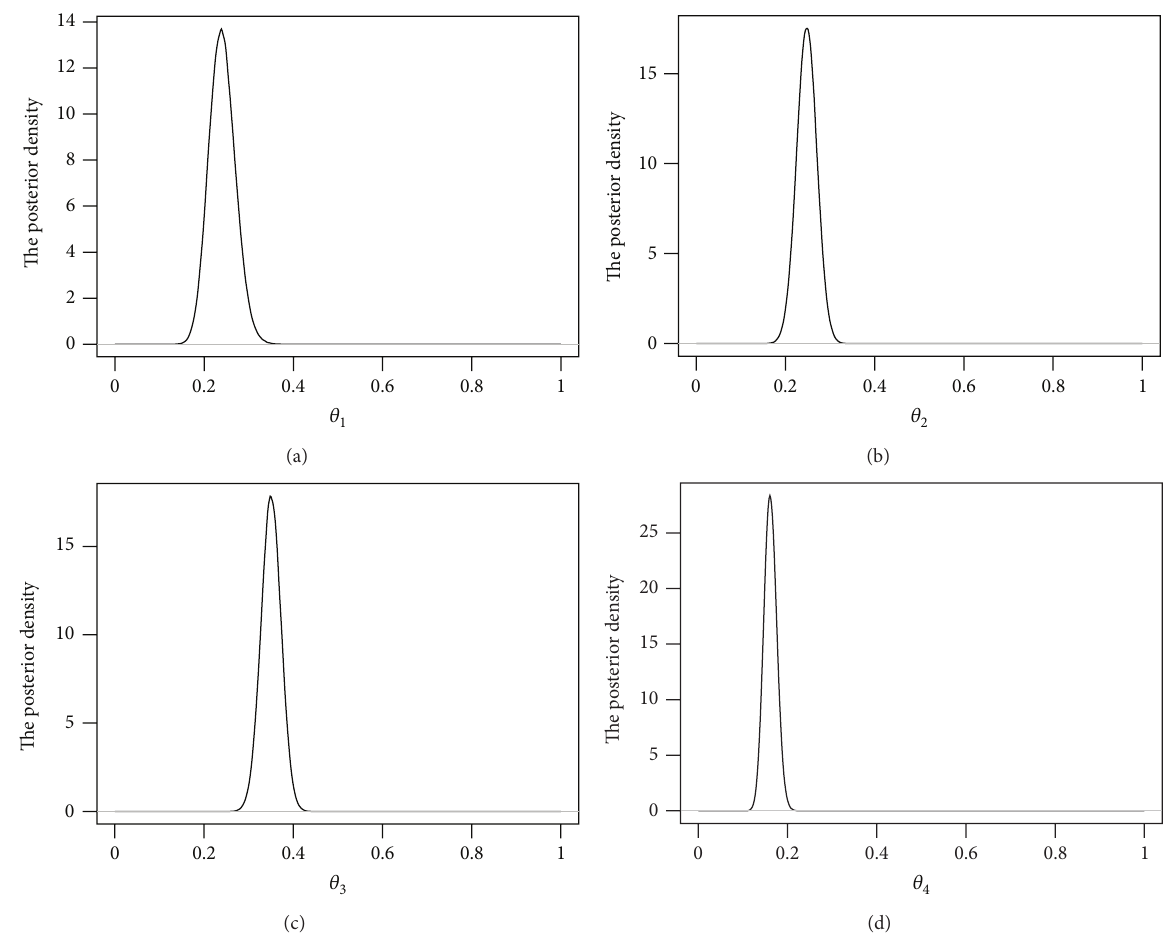
Figure 1: The posterior densities of the {𝜃 𝑖 } 4 𝑖=1 estimated by a kernel density smoother based on the second 500,000 posterior samples of 𝜃 generated by the data augmentation algorithm when the prior distribution is Dirichlet (1,1,1,1) . (a) The posterior density of 𝜃 posterior density of 𝜃 2 ; (c) The posterior density of 𝜃 3 ; (d) The posterior density of 𝜃 4 .